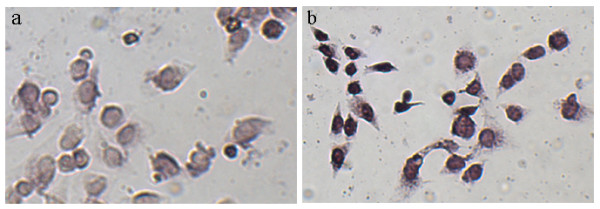
Apoptosis induced by depletion of β-catenin. HeLaT-β-catenin-RNAi cells were grown on coverslips and treated without (a) or with (b) DOX. After 3 days, cells were analyzed for apoptosis with the TUNEL assay. Dark-blue staining of nuclei indicates apoptosis.